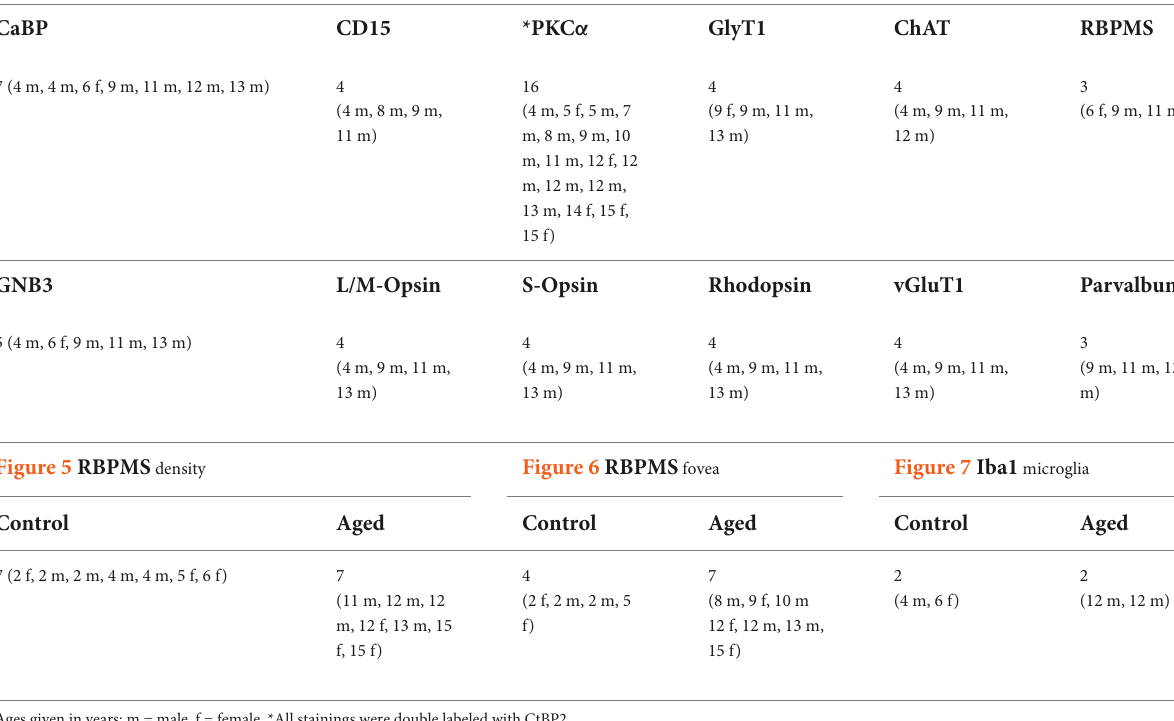
TABLE 2 Number of animals used for immunostaining (age and sex in brackets).